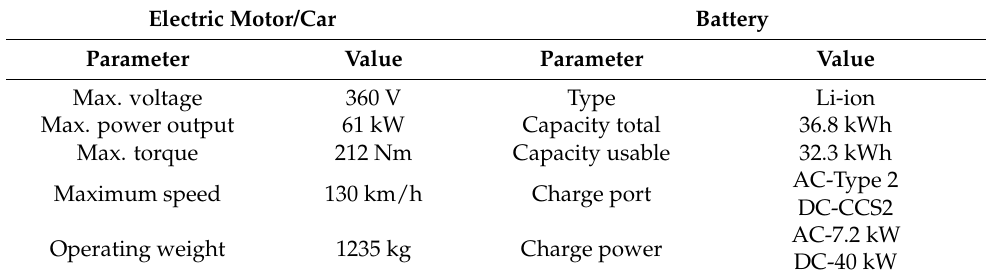
Table 1. Technical data of the analyzed powertrain fitted in ŠKODA CITIGO e iV [34].